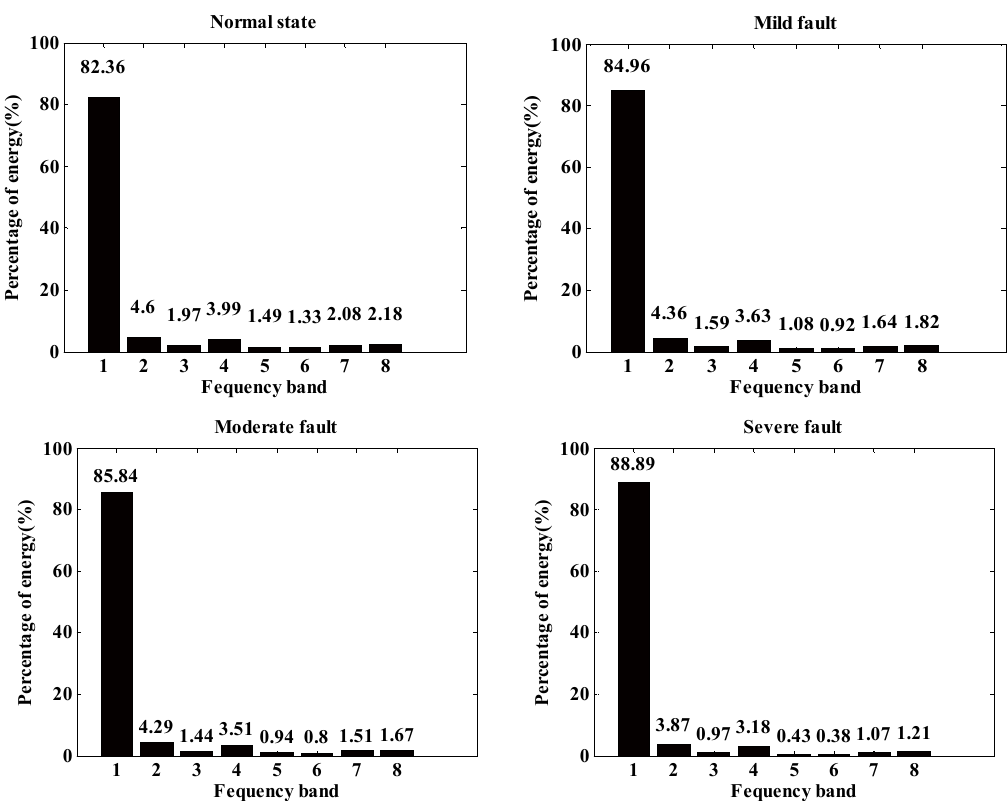
Figure 2. Transformer vibration signal Frequency-Band-Energy (FBE) Histogram.